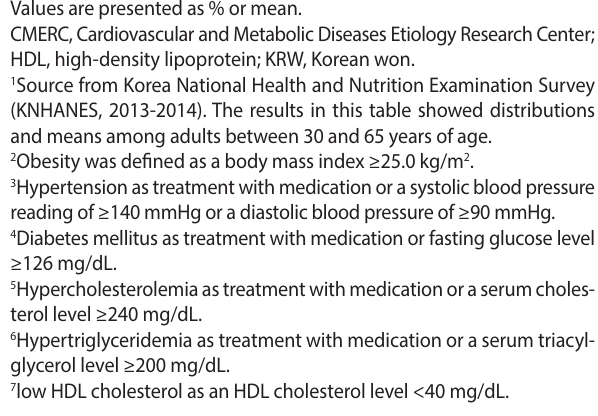
Table 1. Eligibility criteria for the cohort participants